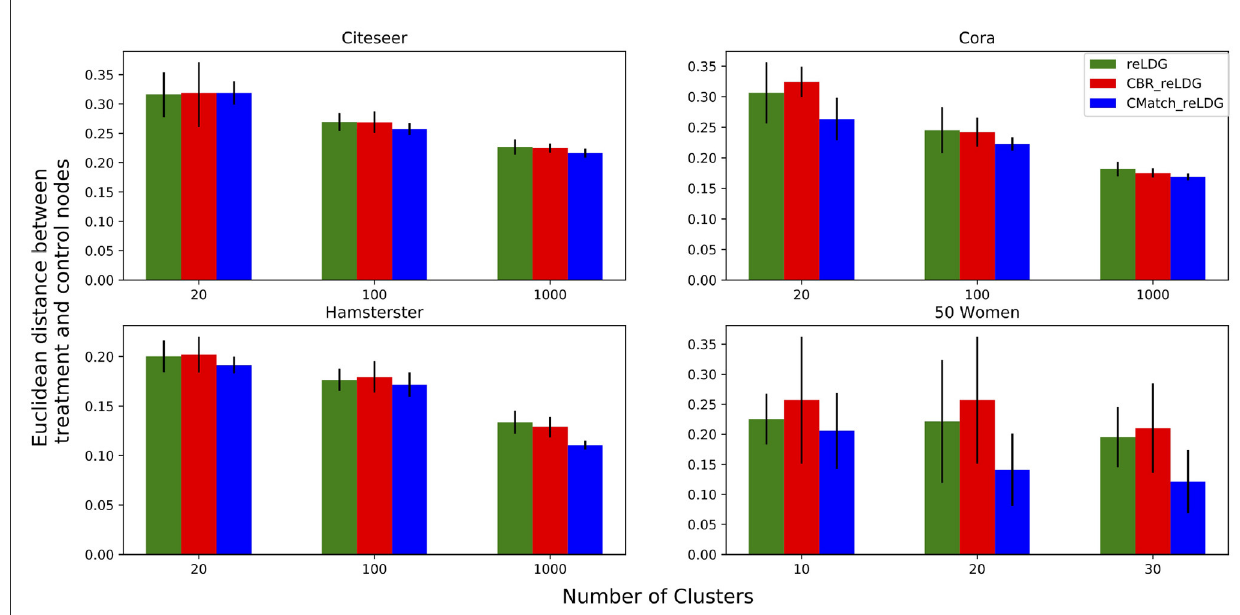
FIGURE13 Euclidean distance between the attribute vector means of treatment and control nodes for a different number of clusters. The higher the number of clusters, the lower the selection bias.